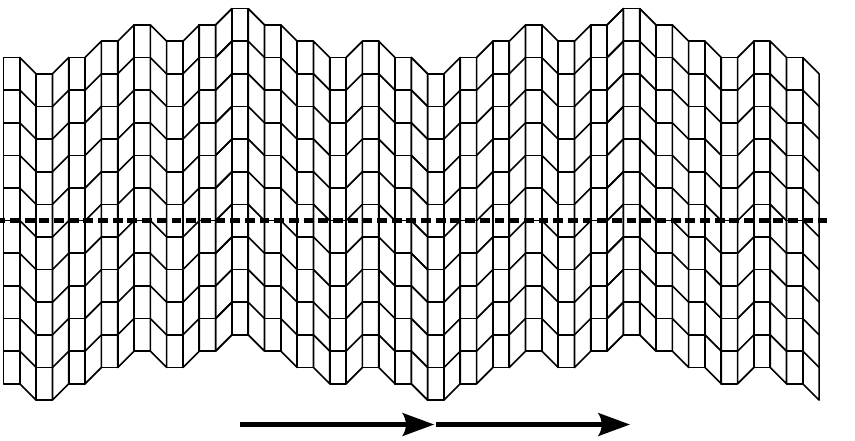
Fig. 65: A crystallographic tiling where layers repeat according to the periodic sequence . . . 111011000100 . . . . It is not invariant under any reflection, but it is invariant under a glide reflec- tion: a reflection in the axis indicated by the dashed line, followed by a translation indicated by one of the arrows.